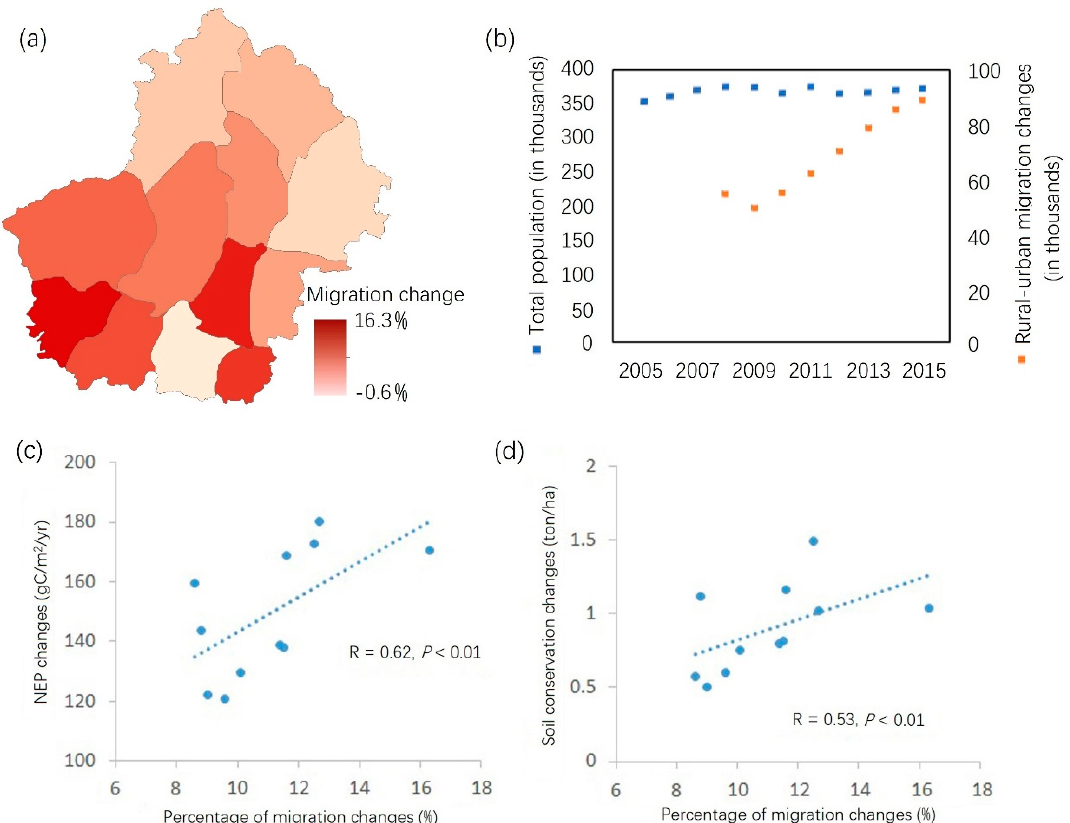
Figure 8. Changes in rural–urban migration from 2005 to 2015 and its correlation with ecosystem services in the Huanjiang County. ( a ) The distribution of the percentage of rural-urban migration changes from 2005 to 2015; ( b ) comparison of total population and rural–urban migration; ( c , d ) correlations between the percentage of rural-urban migration changes and ecosystem services.